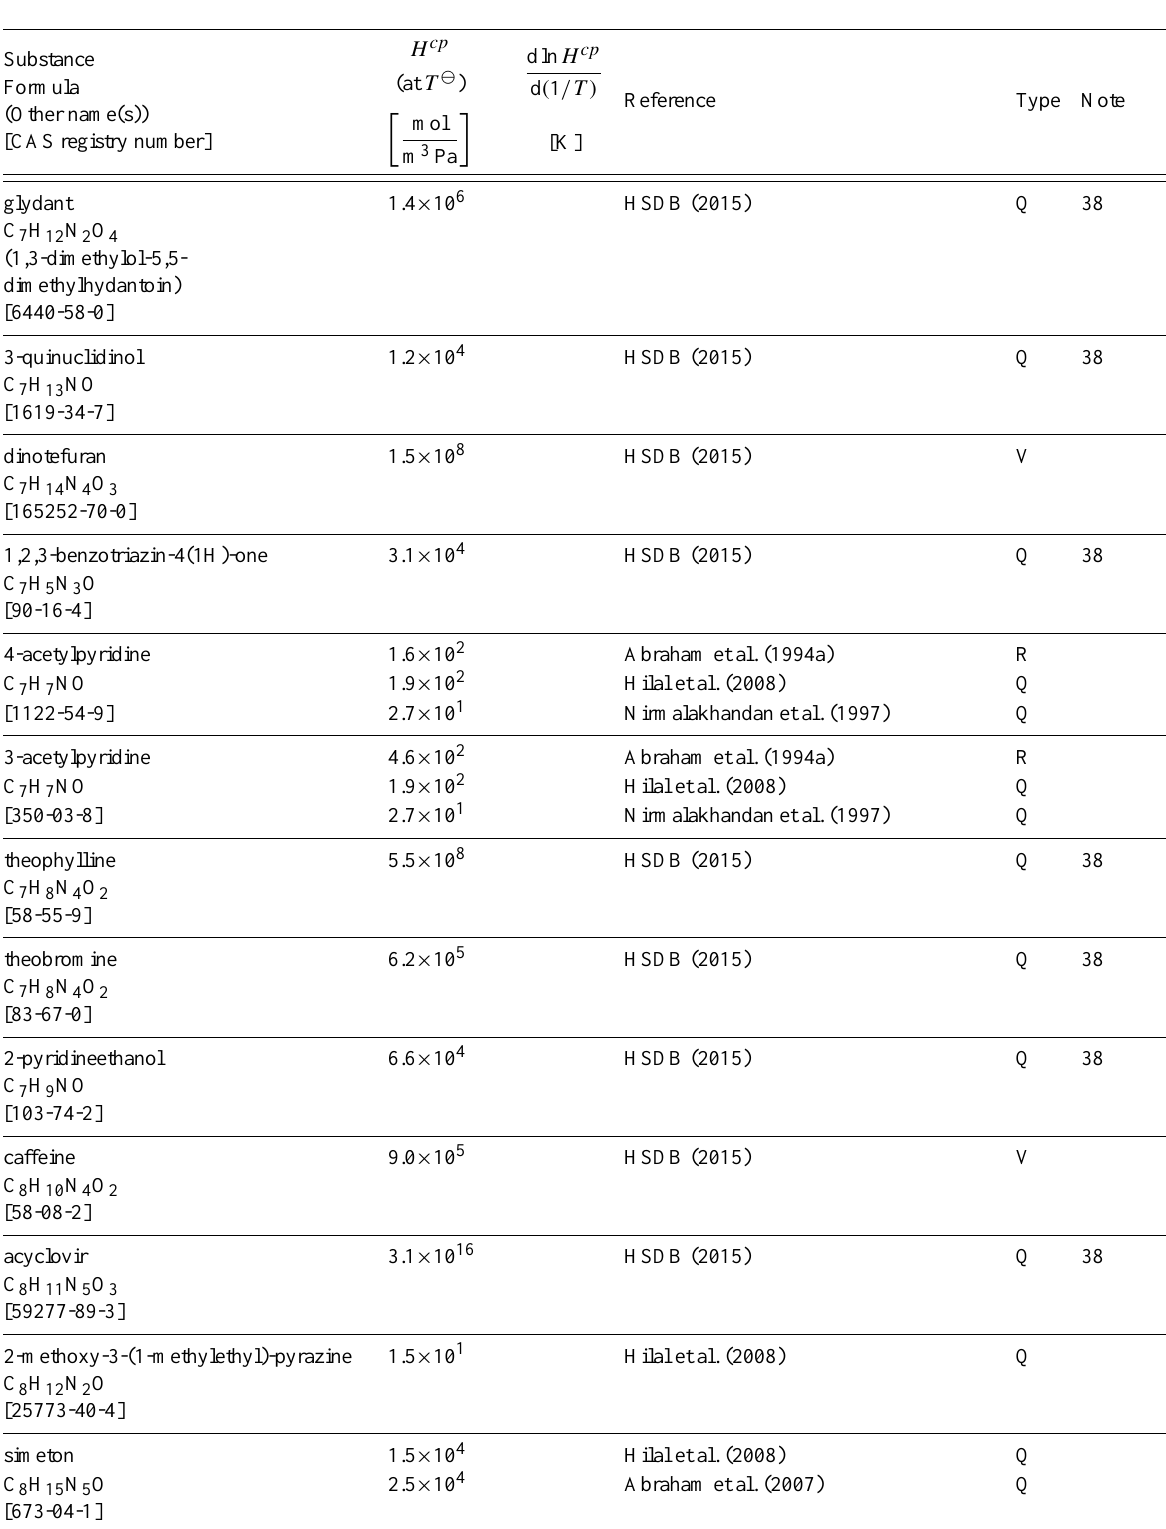
Table 6: Henry’s law constants for water as solvent